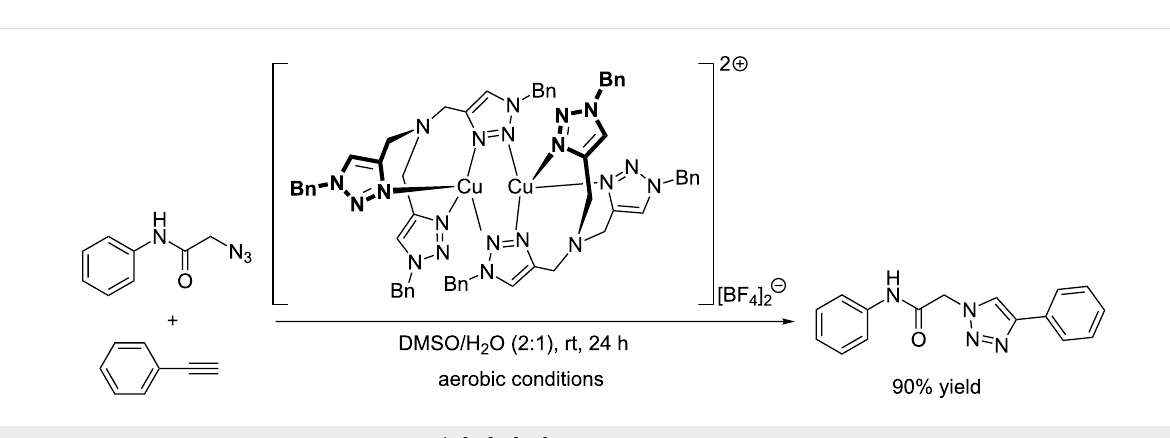
Scheme 8: CuAAC model reaction with [Cu 2 ( μ -TBTA- κ 4 N 2 , N 3 , N 3 ’ , N 3 ’’ ) 2 ][BF 4 ] 2